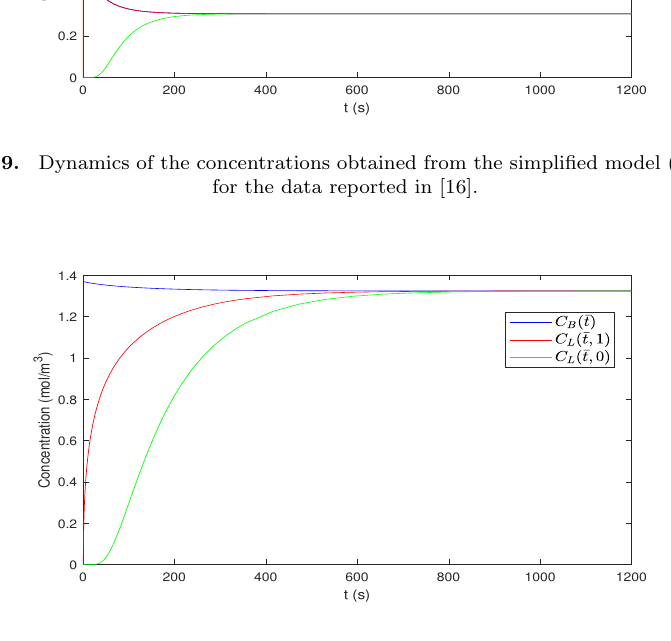
Figure 10. Dynamics of the concentrations obtained from the simplified model ( α/β ≈ 0 . 1) for the data reported in [16]. After performed simulations we see that the linearized and